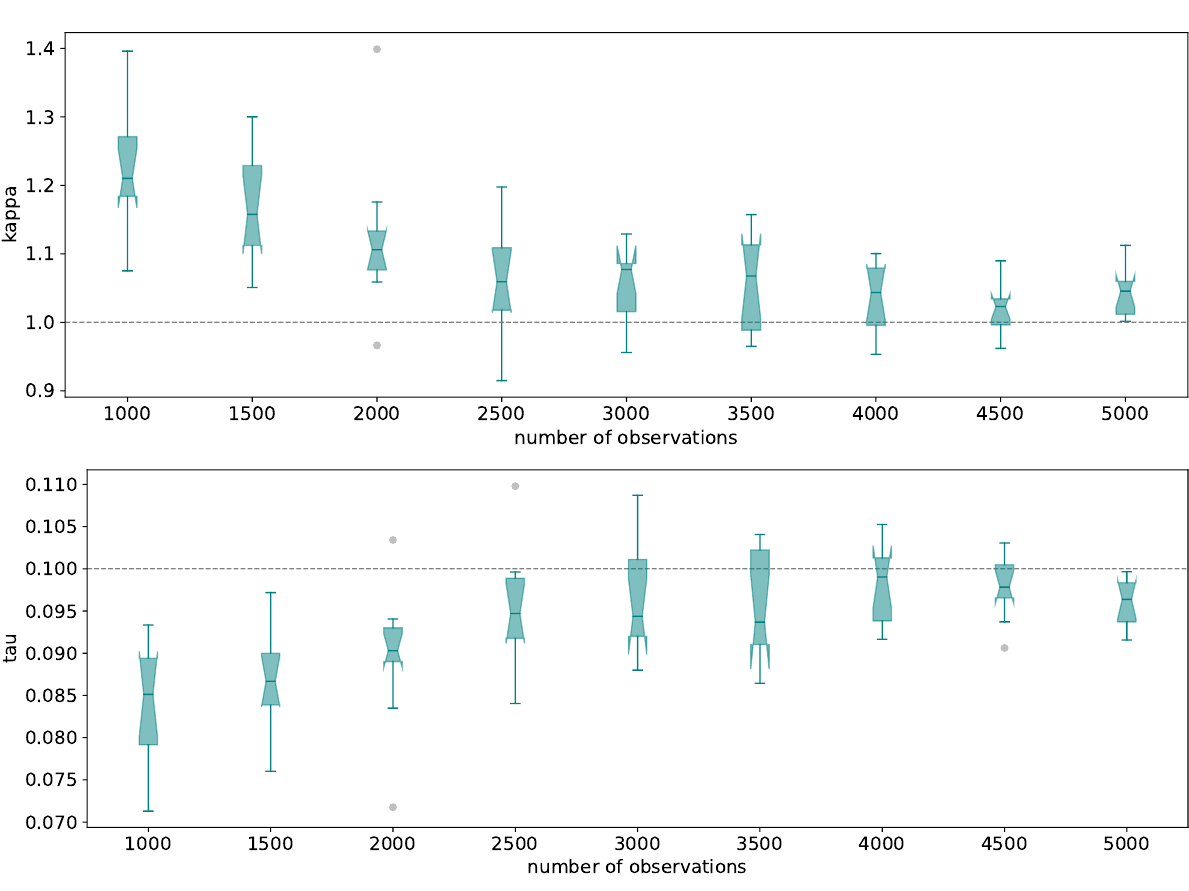
Figure 8 Estimates of τ (top panel) and κ (bottom panel) compared to ground true values τ ∗ = 0 . 1 and κ ∗ = 1 . 0, shown using dashed lines in both panels. Shape parameters are estimated reasonably well, with less bias evident as the number of observations